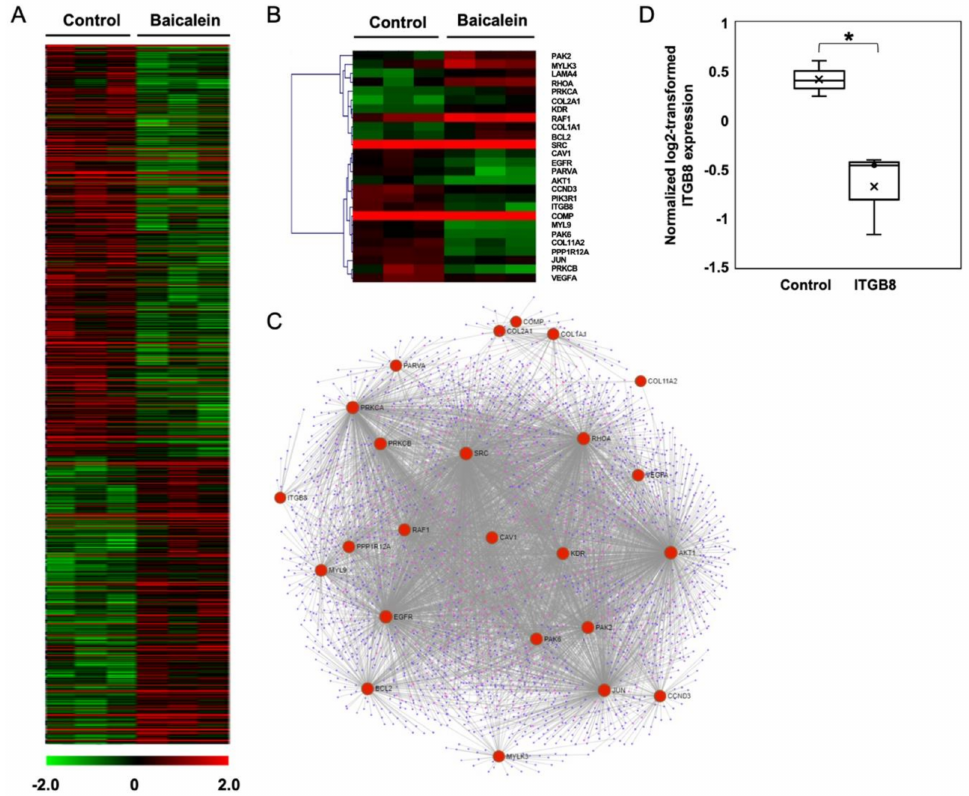
Figure 3. Transcriptomic profiles of NPC cells upon exposure to baicalein. ( A ) An illustration of a heatmap of hierarchical clustering of all 1274 DEGs between baicalein-treated and control HK-1 cells. ( B ) A heatmap of DEGs between the baicalein-treated and cell control groups, which are involved in the focal adhesion pathway as enriched by KEGG pathway analysis. The heatmaps were constructed using the hierarchical clustering function in the MeV program at a level of confidence * p < 0.05. As indicated in the diagram, a gradient of colors from red to green represents upregulation to downregulation. ( C ) An undirected protein-protein interaction network of DEGs with nodes highlighted on genes in the focal adhesion pathway using Network Analyst software. ( D ) A box plot of normalized log2-transformed values of integrin β 8 was obtained from transcriptome